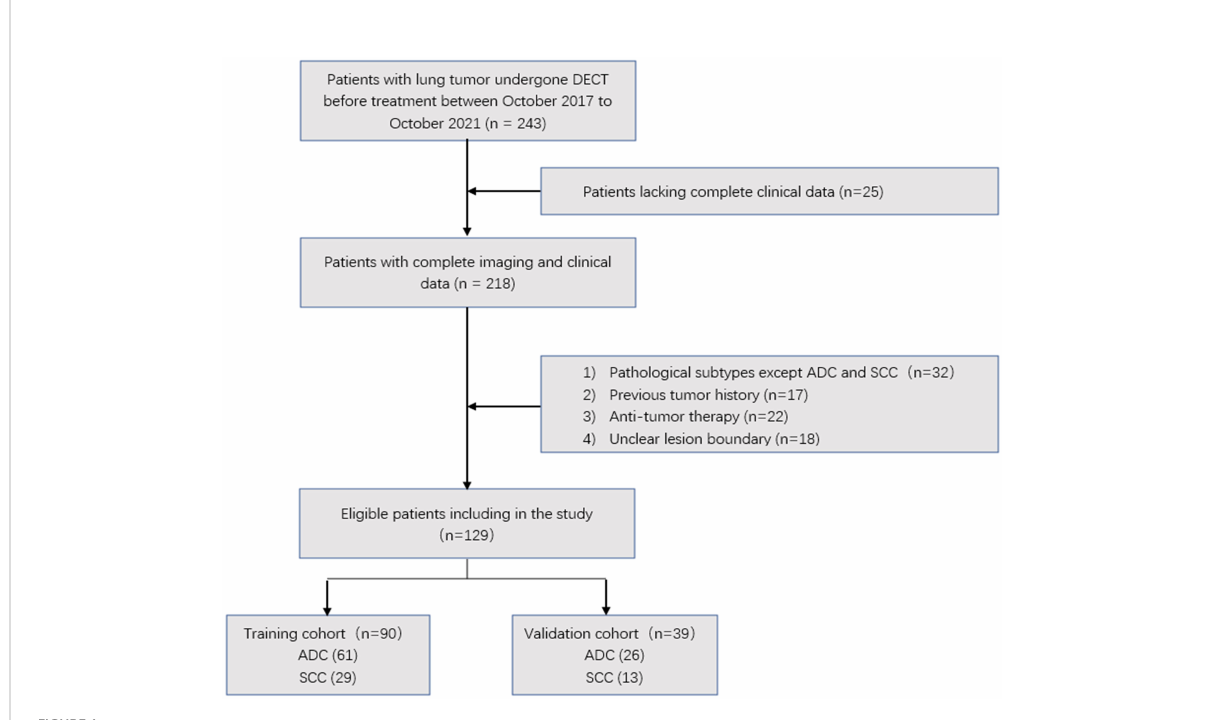
FIGURE 1 Flow chart showing the patient selection and